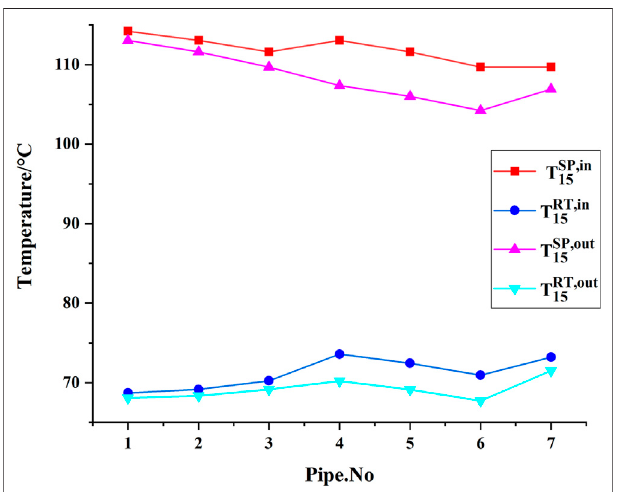
FIGURE 12 | The temperature of supply and return system at on- peak time.